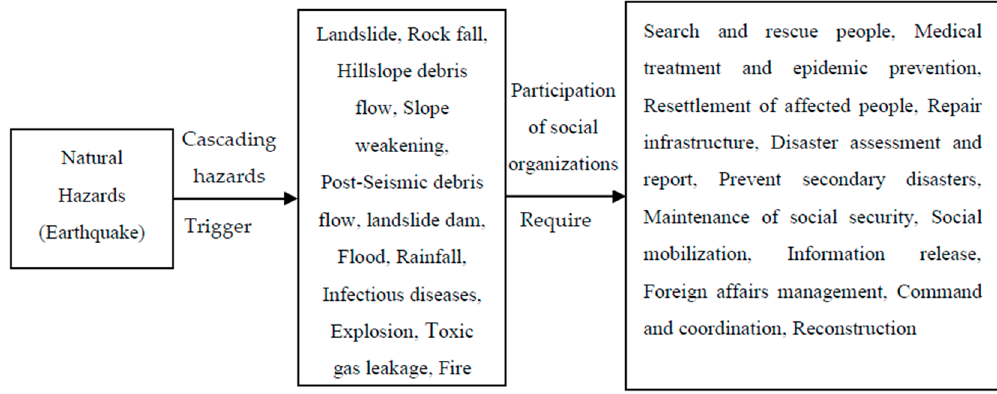
Figure 6. The relation between cascading hazards and social organizations' participation.